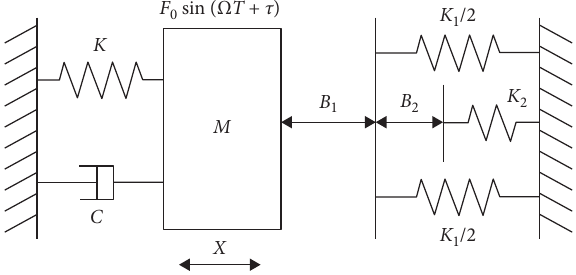
Figure 1: Physical model of a single-degree-of-freedom vibroimpact system with multilevel elastic